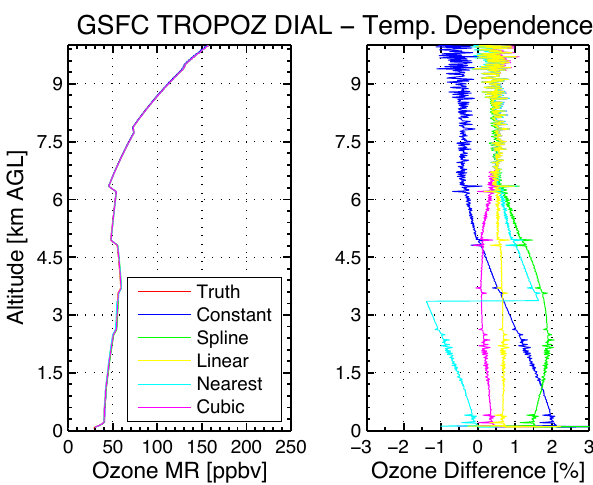
Figure 4. The left panel shows the retrieved ozone mixing ratios from the corrected and uncorrected TROPOZ ozone profiles as compared to the known ozone profile used in the simulated lidar return signal.The right panel shows the percent difference from the known profile and retrieved